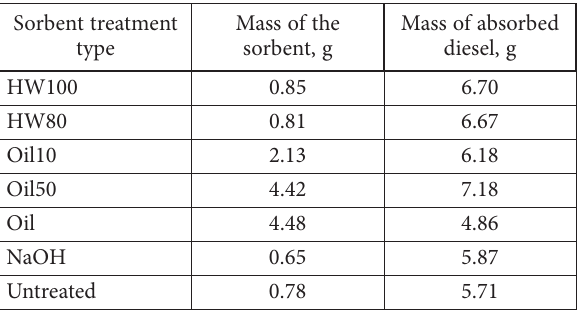
Table 1. Diesel sorption data